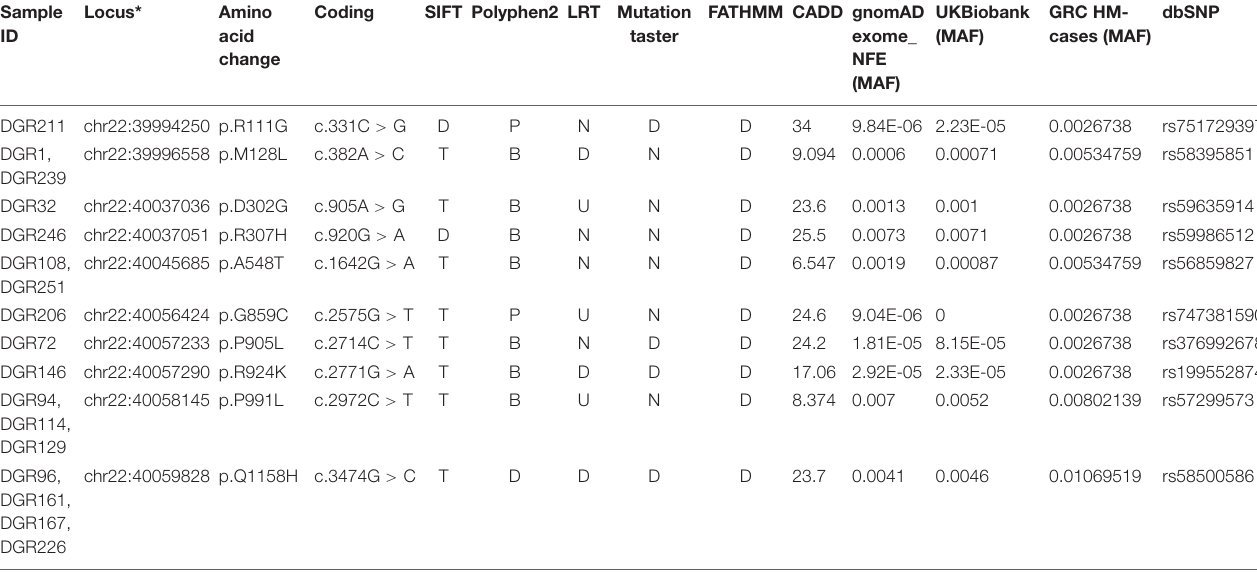
TABLE 1 | Rare functional variants ( n = 10) identified in CACNA1I in 187 cases clinically diagnosed with